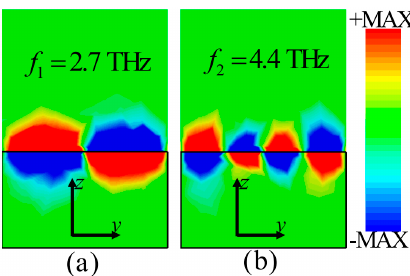
Figure 3. The electric field ( E z ) distributions of the y – z plane of the unit cell structure at ( a ) f 1 = 2.7 THz and ( b ) f 2 = 4.4 THz, respectively ( E f = 0.8 eV).